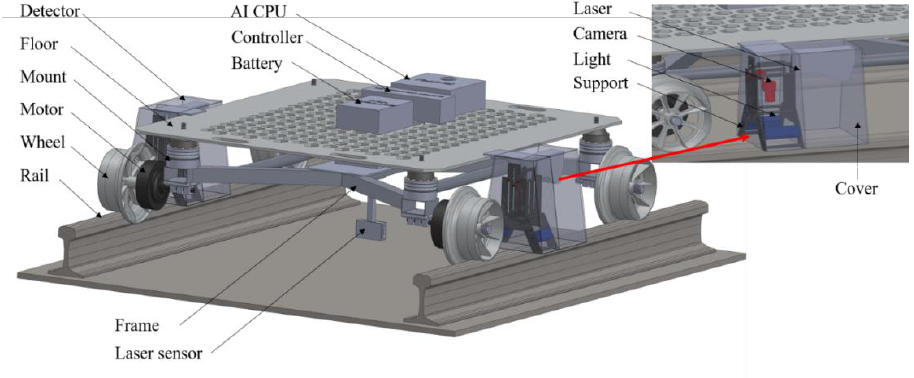
Figure 1. The proposed configuration of the RSD inspection car.